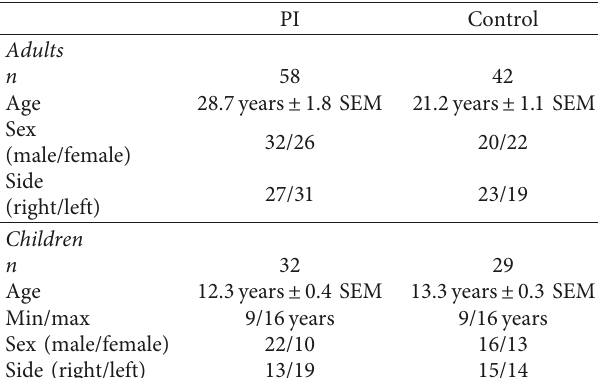
Figure 1: Measurement technique for the TTPCL/THD. Representative T2 MRI sequences acquired from a healthy 9-year-old boy. The mediolateral tibial tubercle-posterior cruciate ligament (TTPCL) distance was measured from (a) the medial border of the tibial insertion of the posterior cruciate ligament (PCL) and (b) the midpoint of the tibial tubercle (TT). The distance was measured parallel to the dorsal tibial condylar line (dTCL). The bony margins in the MRI scans were utilized except when measuring the tibial head diameter (THD).To determine the THD, the transversal plane with the maximum diameter of the tibial head was identified by the examiner (c). Table 1: Patients’